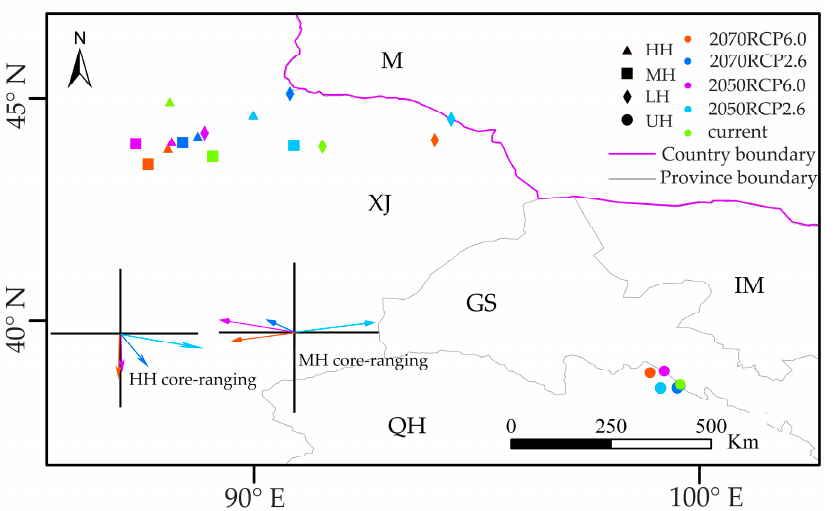
Figure 5. Range shifts of four habitats under RCP2.6 and RCP6.0 scenarios. Lines with color show the direction and distance of core change from current (start of line) to specific time (end of arrow) in MH and HH, and the color of the line depicts the specific time. UH: unsuitable habitat; LH: low suitable habitat; MH: middle suitable habitat; HH: high suitable habitat; M: Mongolia; IM: Inner Mongolia; XJ: Xinjiang; GS: Gansu; QH: Qinghai.